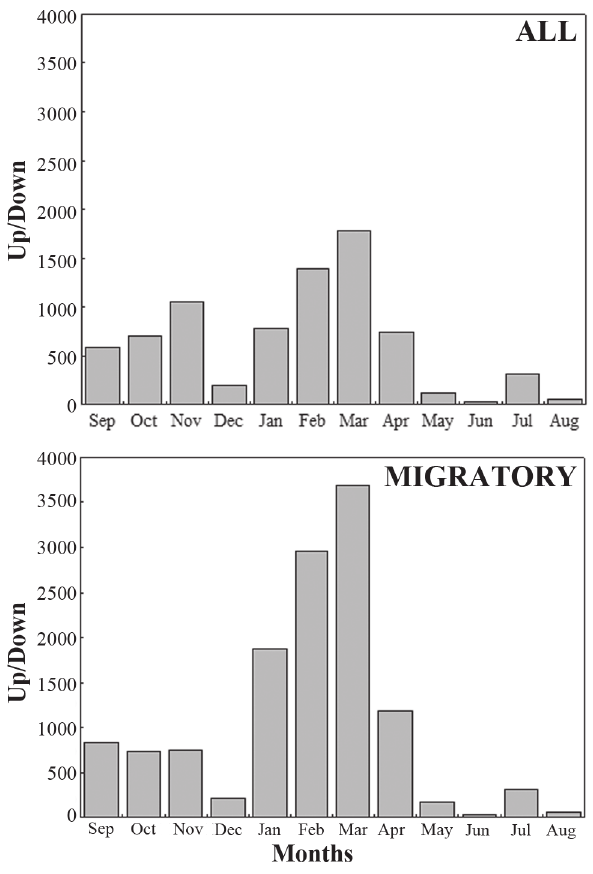
Fig. 4. Density of fish (ind./m 2 ) descending (DOWN) and ascending (UP) through the ladder between September 2009 and August 2010 (dots represent monthly samples; N = 12).